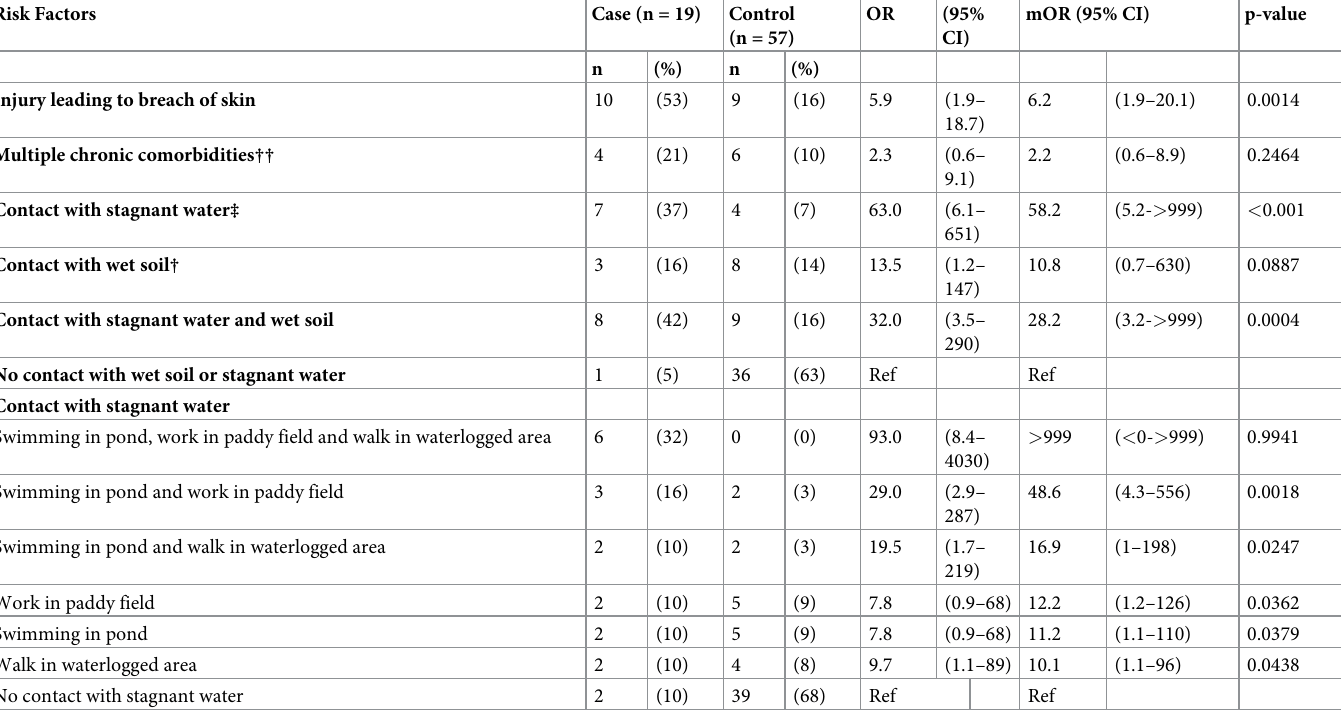
Table 1. Risk factors associated with melioidosis in Udupi district